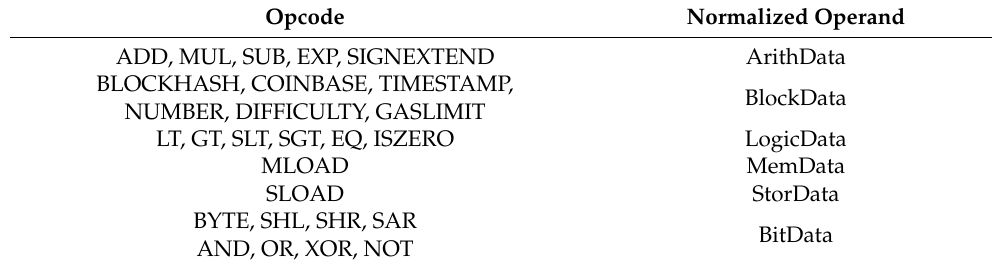
Table 2. Operand